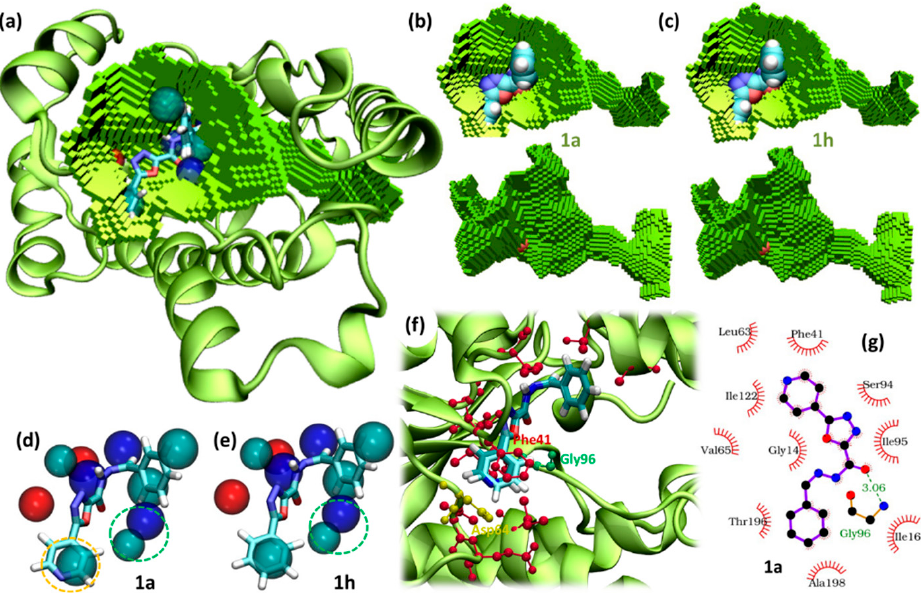
Figure 2. Docking results and pocket analysis: ( a ) overview of the overall results with lowest scoring docking poses of the two substrates, pocket (squared surface), and calculated pharmacophore features (transparent spheres); ( b , c ) fit between docking poses and pocket; ( d , e ) comparison between docking poses and target based pharmacophore, color code: cyan (hydrophobic center), blue (h-bond acceptor center), red (h-bond donor center), a yellow circle highlight the mismatch between the neutral pharmacophoric bead and the mismatching pyridine ring of 1a , a green circle highlights room for further functionalization; ( f ) three-dimensional arrangement of interacting residues and ( g ) two-dimensional visualization. The highlighted residues interact with both substrates with Van der Waals (red). Gly96 (green) is forming a hydrogen bond with both 1a and 1h .